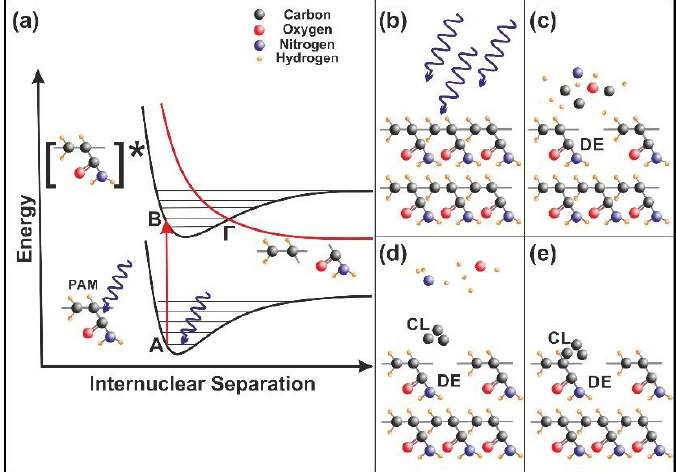
Figure 11. Nanocavitation by 157 nm laser photodissociation of polyacrylamide (PAM) matrixes: ( a ) Molecular photodissociation at 157 nm. Vertical arrows indicate photon transitions between two vibrational levels of the ground (A) and an excited electronic state (B). A transition from the excited to a repulsive electronic state (red curve) through an avoided crossing via a vibration state at the point ( Γ ) is very fast ( < 1 ps) and breaks a molecular bond in the polymeric chain; ( b ) PAM surface irradiation with 157 nm photons; ( c ) (DE): a bond break is followed by molecular decomposition and nanocavitation; ( d ) (CL): possible recombination of carbon dissociative products, and cluster formation in the gas phase; ( e ) carbon cluster deposition on the polymeric matrix and possible structure of carbon nanocavitation.